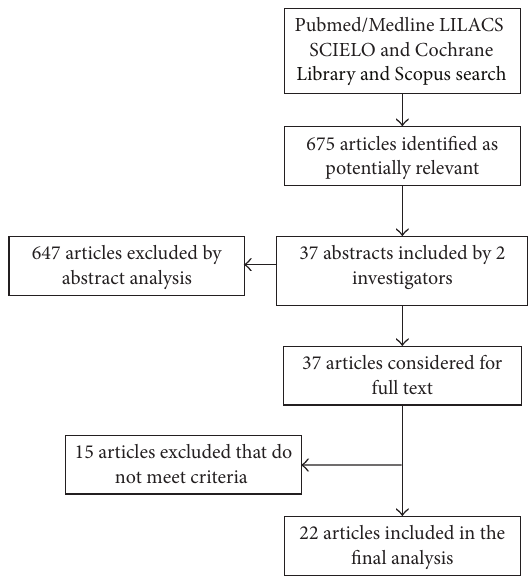
Figure 1: Research process